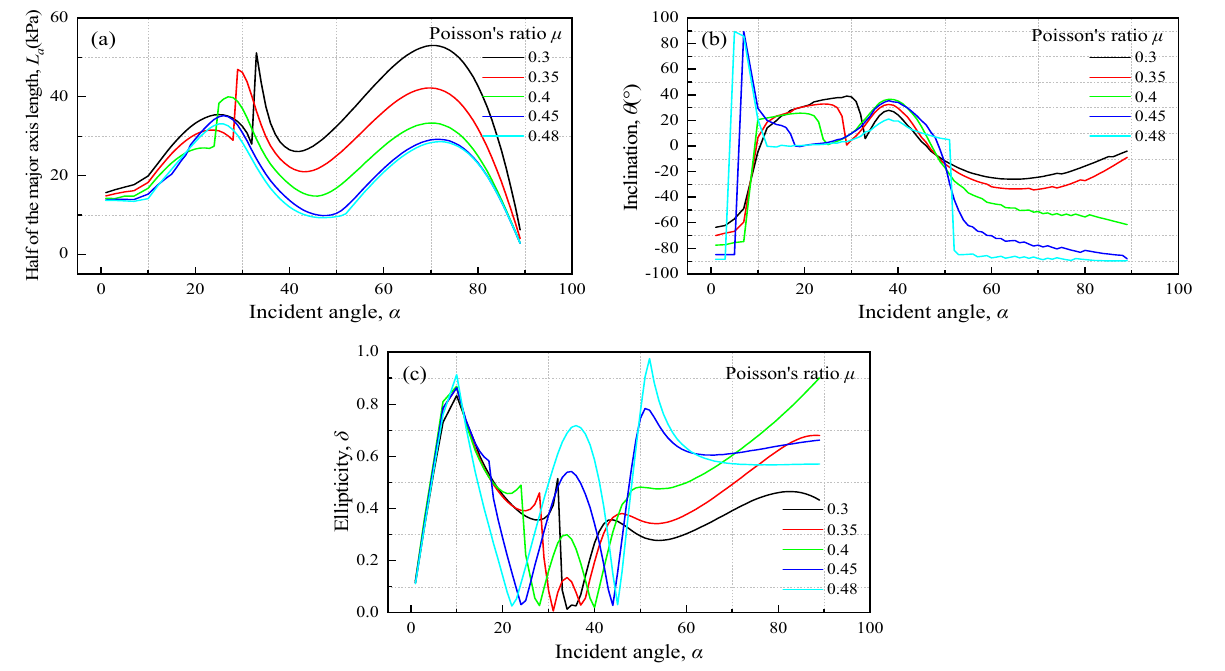
Figure 5. Variation of characteristic parameters of elliptical stress path with the incidence angle for various Poisson’s ratio.